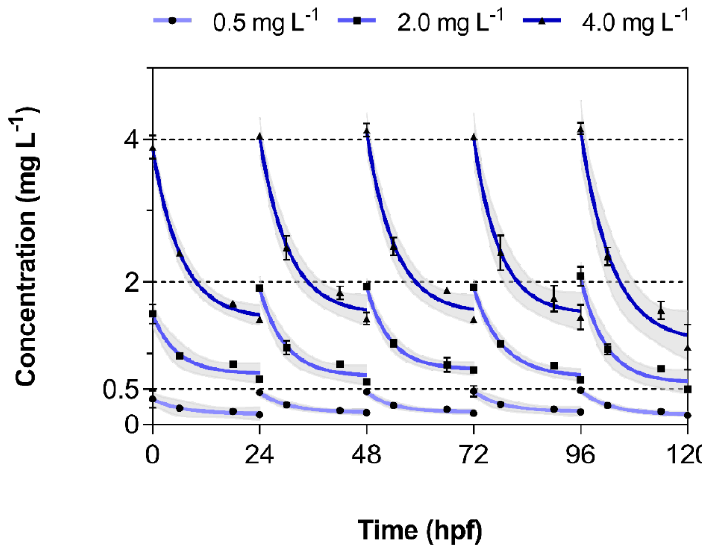
Figure 2. Measured concentration of 3,4-dichloroaniline (3,4-DCA) in exposure solutions during incubation with three different exposure concentrations (0.5, 2.0, and 4.0 mg L −1 ). Data represent the average ± standard deviation of measured 3,4-DCA concentration in n = 2 independent replicates. Dashed lines represent nominal exposure concentrations. The shaded area indicates the 95% confidence interval of the fitted one-phase exponential decay regression line.